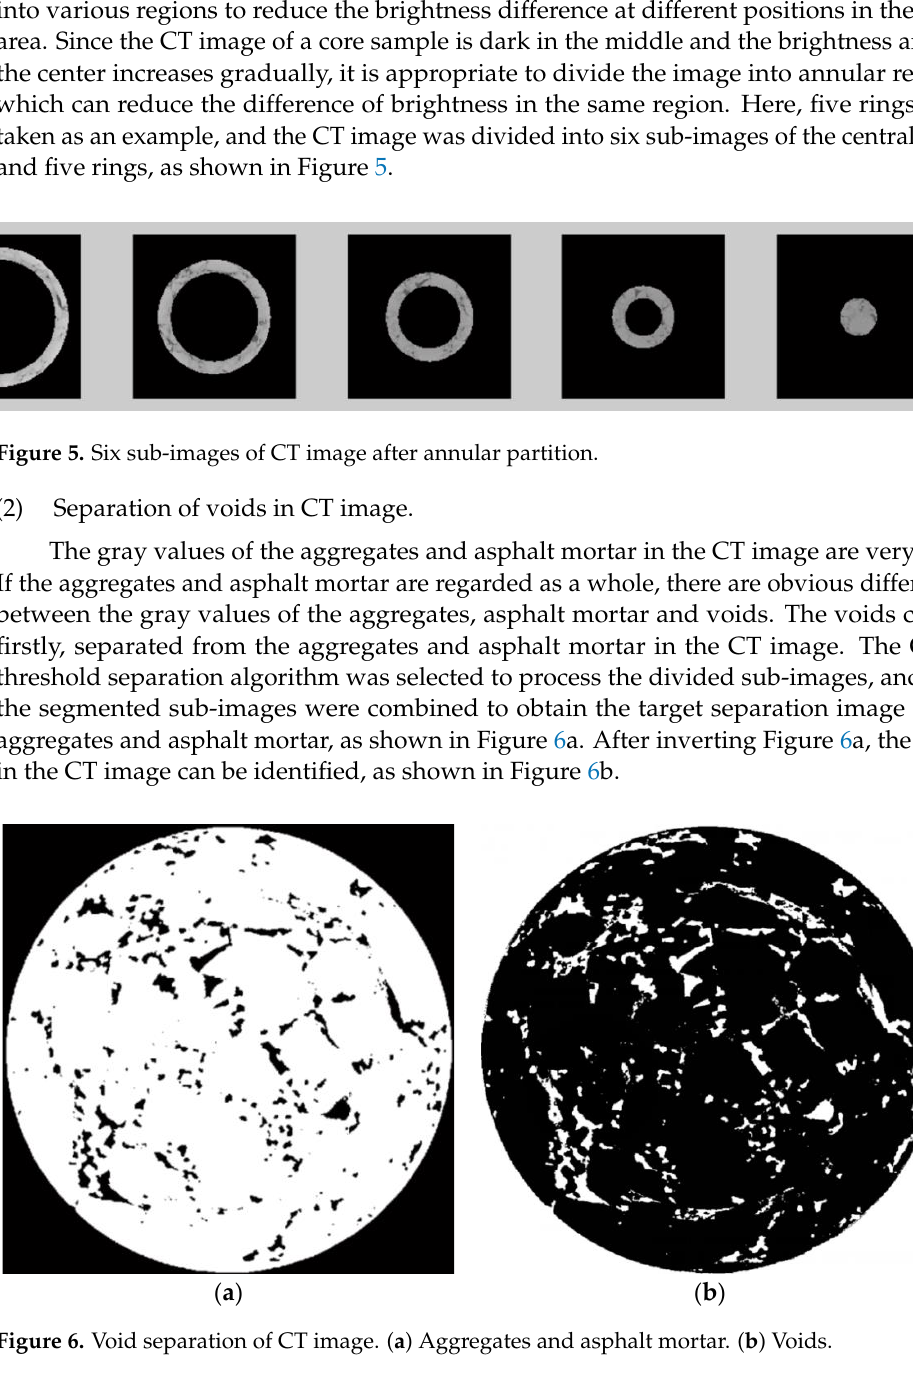
Figure 4. CT image of core sample for asphalt pavement.